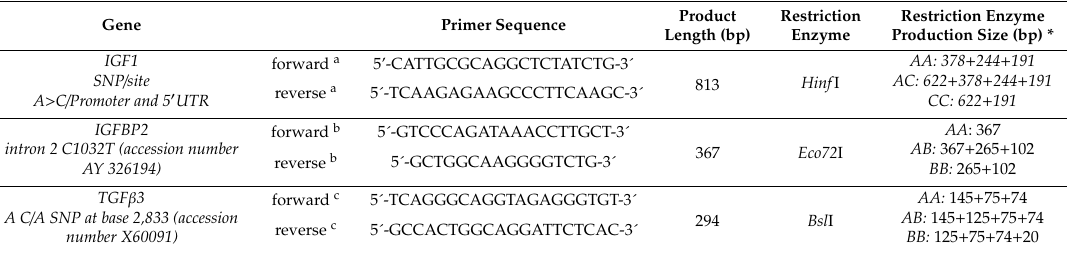
Table 3. Primers used in polymerase chain reaction (PCR)